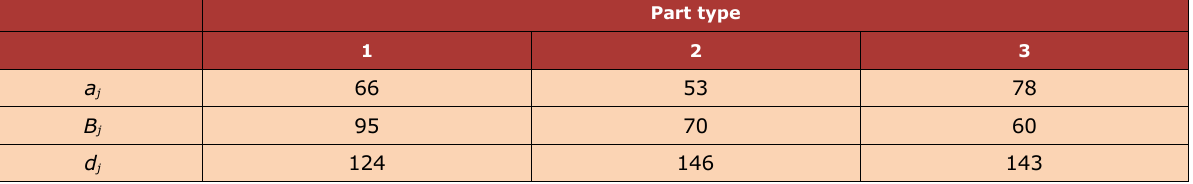
Table 4. Values of aj, Bj and dj